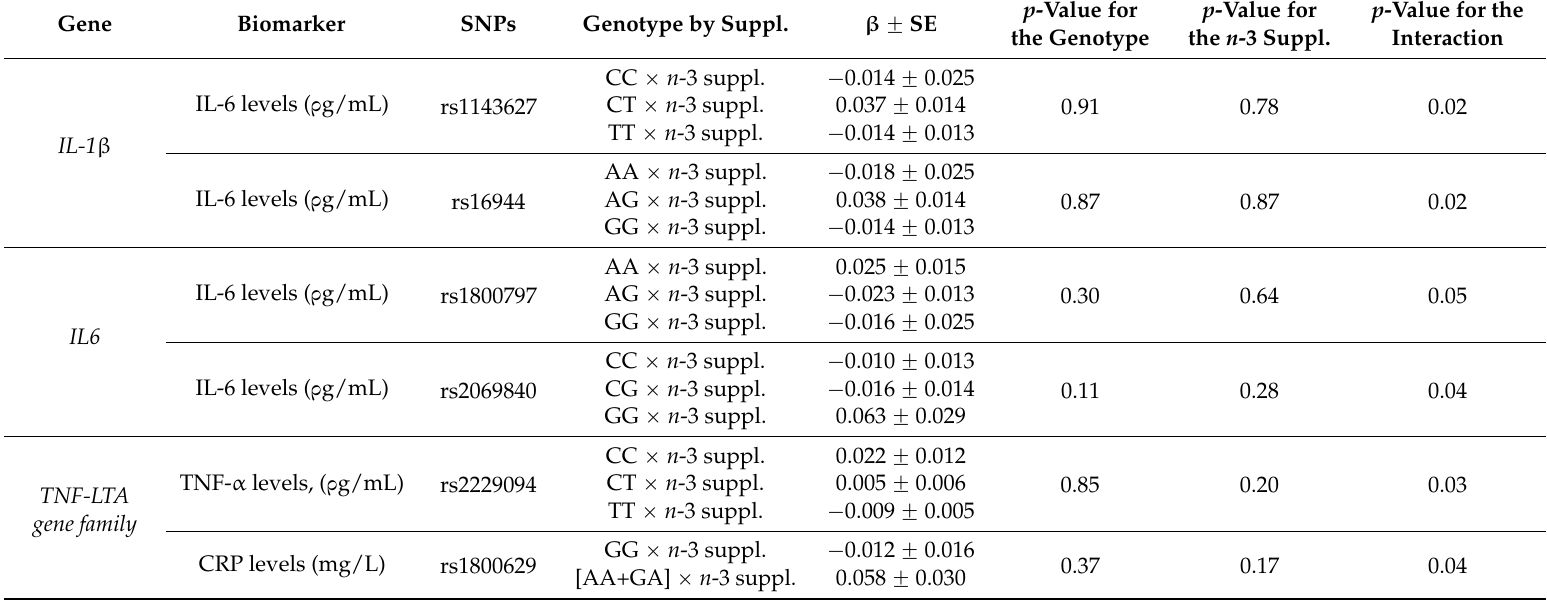
Table 5. Gene–diet interaction on inflammatory markers